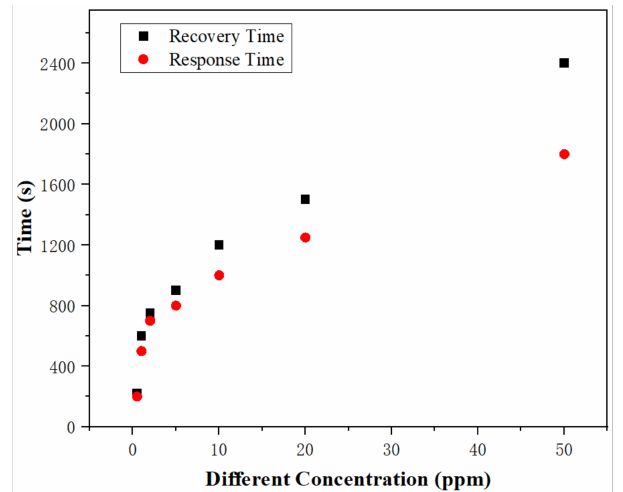
Figure 7. Response and recovery times of the PAA SAW ammonia sensor at different concentrations of